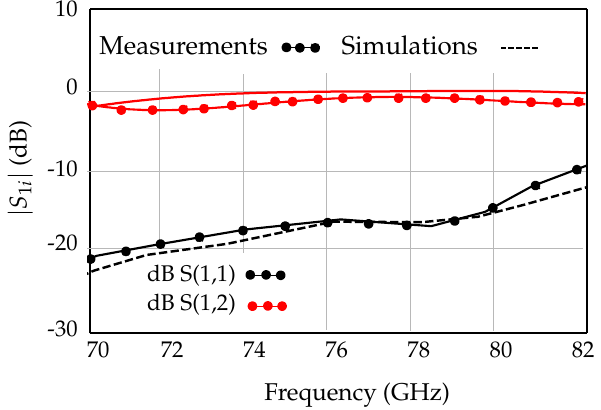
Figure 10. WR-12 waveguide to microstrip line transition.